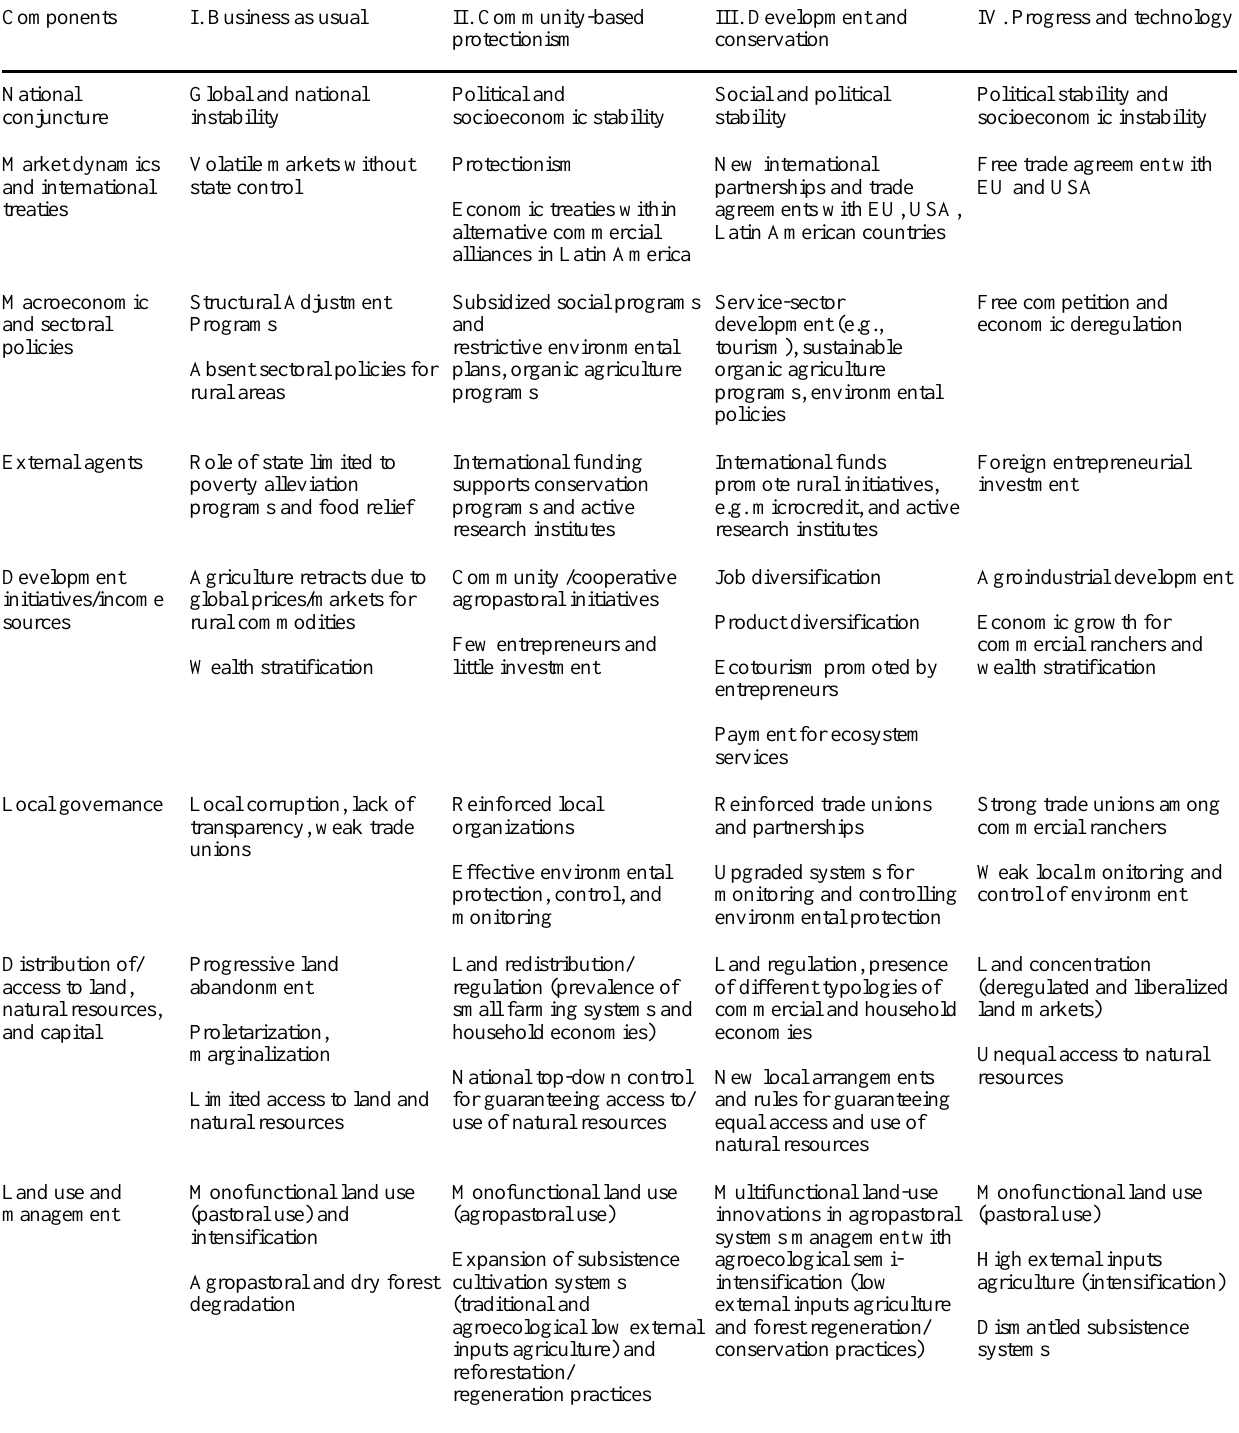
Table 3. Overview of the main differences between drivers/components of the four participatory socioeconomic scenarios for the area for